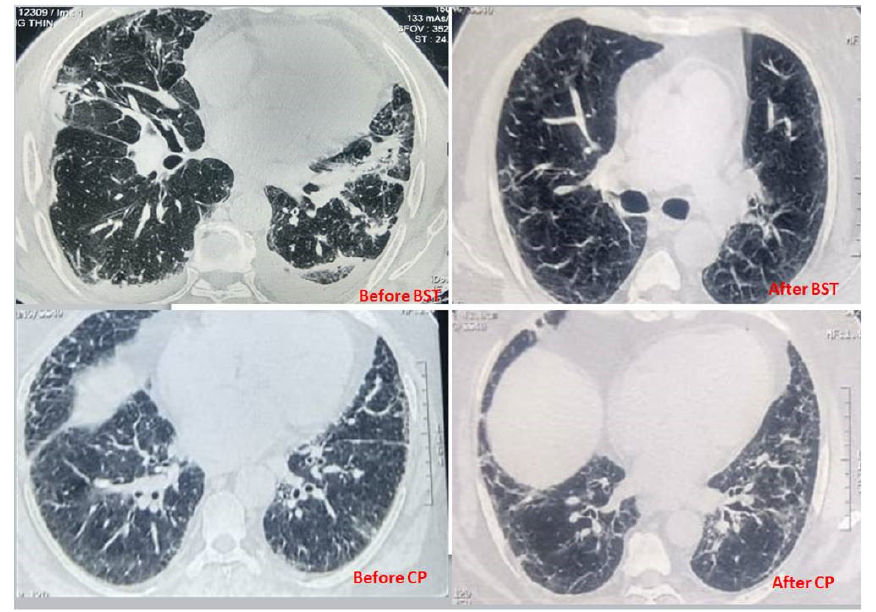
Figure 2. Chest CTs of patients before CP/BST therapy and after CP/BST therapy showing ground glass opacity, uneven density in multiple lung lobes, and multiple shadows of high density.